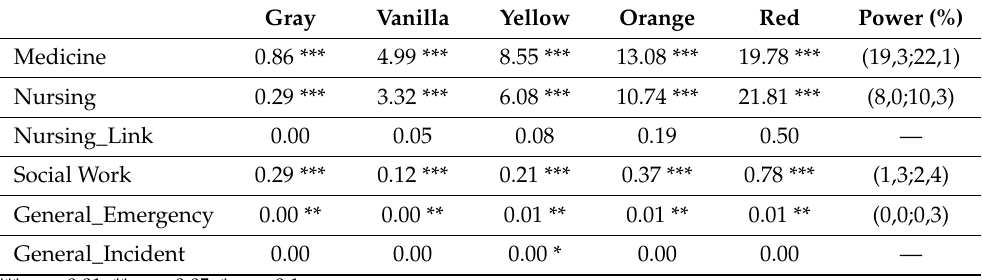
Table 11. Consultations performed in primary care for persons over 65 years of age living alone based on the color of the patient AMG triangle in Drago-EHRPC. Basic Health Areas of Gran Canaria.